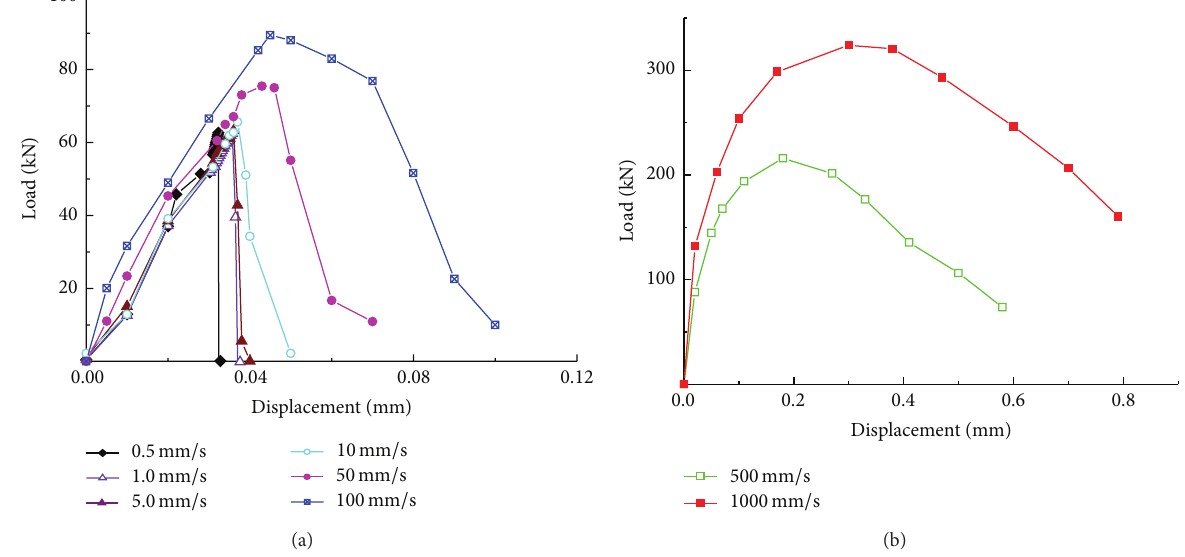
Figure 10: Load versus displacement. (a) V ≤ 100 mm/s; (b) V > 100 mm/s.